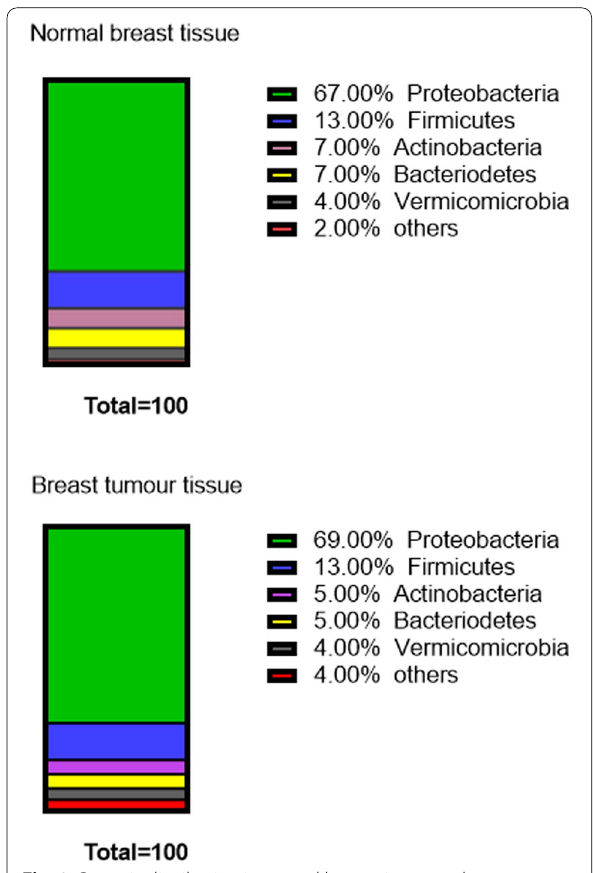
Fig. 2 Bacteria distribution in normal breast tissues and tumour tissues. The relative percentage of bacteria distribution at phylum level as described by Xuan et al.